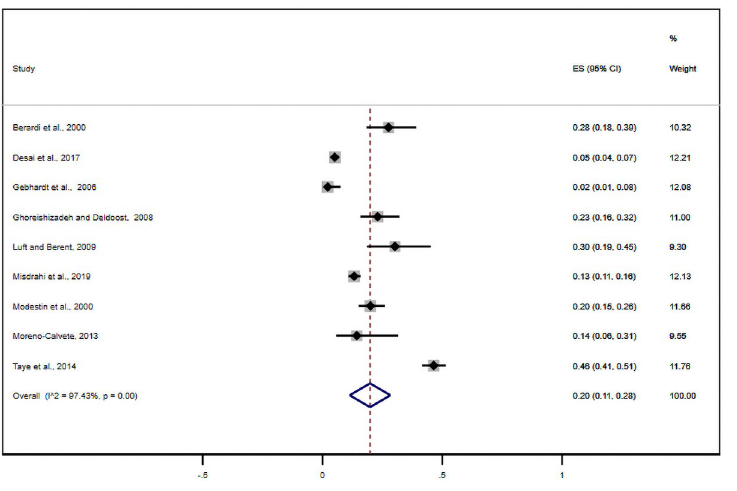
Fig 4. Forest plot depicting anti-psychotic induced parkinsonism.